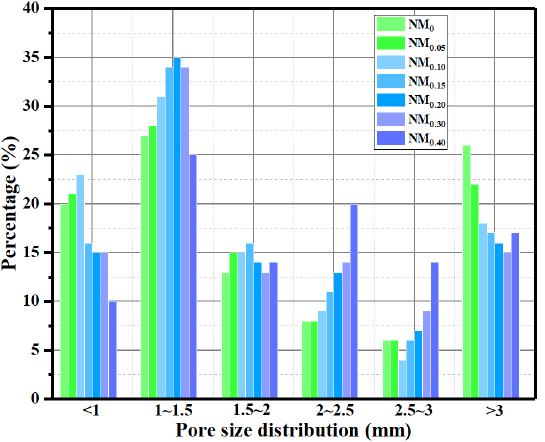
Figure 9. Influence of the content of CHF on the pore size distribution of the material.